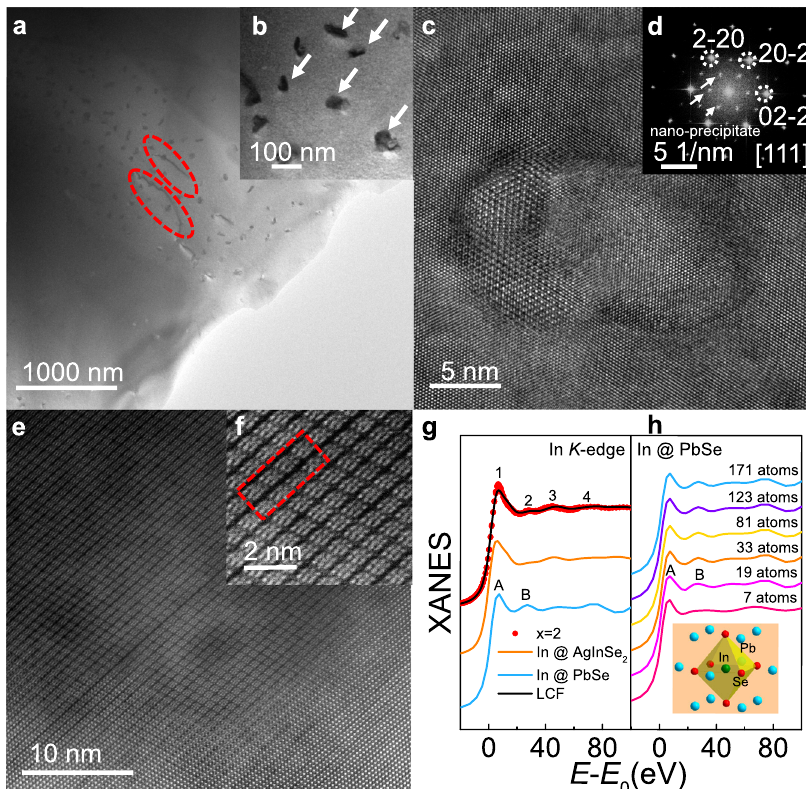
Fig. 7 Microstructures and local structure analysis for high-performance LISS sample. a Low magni fi cation of bright- fi eld TEM image for Pb 0.98 Na 0.02 Se − 2.05% AgInSe 2 sample. b The enlarged TEM pattern presents the nanoscale precipitates remarked by the arrows. c High resolution TEM (HRTEM) picture of a selected nanoprecipitate. d The corresponding selected area electron diffraction (SAED) pattern with cubic structure along [111]. e , f High angle annular dark fi eld (HAADF) patterns for Pb − 2.05% AgInSe K -edge for Pb − 2% AgInSe 0.98 Na 0.02 Se 2 . g Experimental XANES spectra of In 0.98 Na 0.02 Se 2 (red dots), and AgInSe 2 (orange line), respectively. The blue line shows the theoretical XANES spectrum of In K -edge for In-doped PbSe assuming that In occupies the Pb site. The black line represents a linear combination fi tting (LCF) result of In K -edge of Pb 0.98 Na 0.02 Se − 2% AgInSe 2 considering that the In K -edge of AgInSe 2 and In- doped PbSe serves as standards. h Multiple scattering calculations of In K -edge XANES for In-doped PbSe with different atomic clusters. The inset shows the nearest-two shell of In atom when it occupies the Pb site in PbSe matrix. The E 0 is the absorption edge energy of In K -edge of In